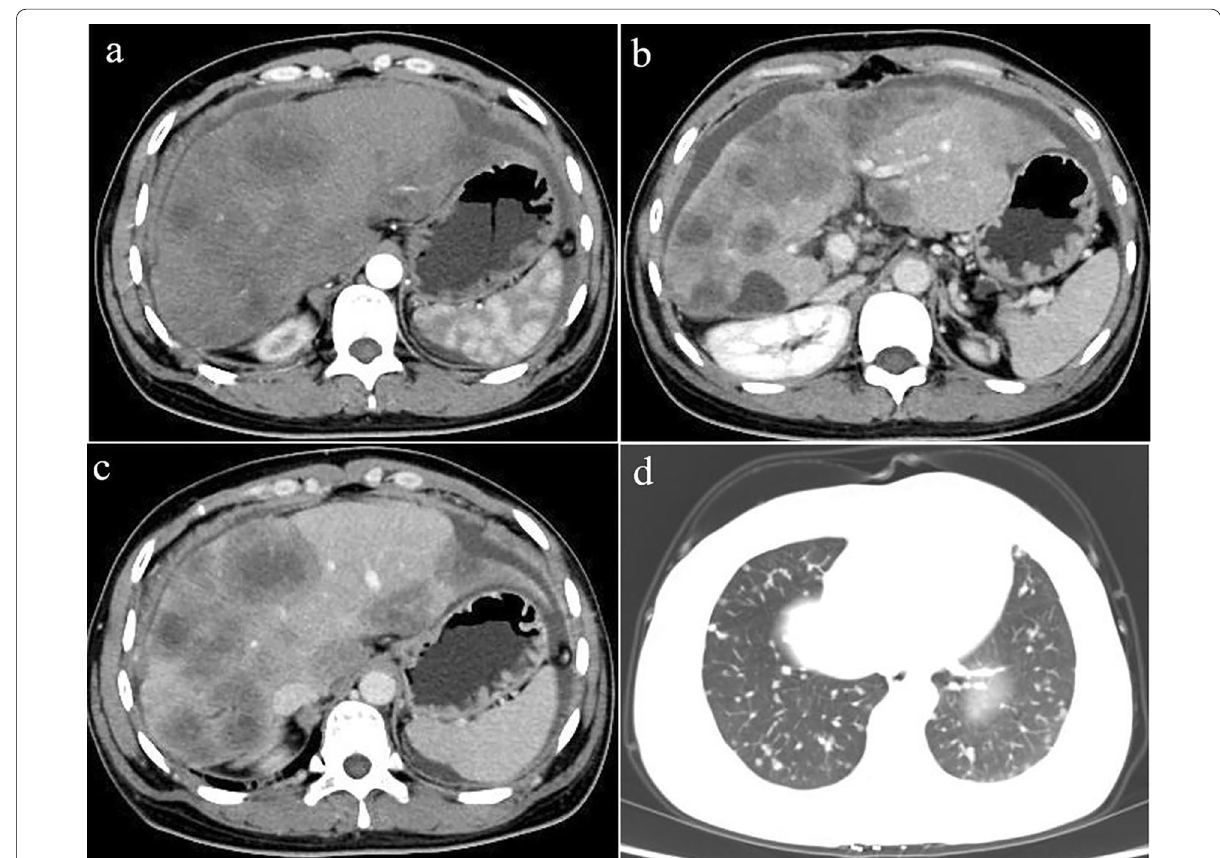
Fig. 5 A 34-year-old female with diffuse nodular type HEH. Axial and multiple phase contrast-enhanced CT images ( a – c ) show multiple, different-sized, coalescing, homogeneous, hypoattenuating nodules diffusing throughout the liver parenchyma. Masses show ring-like enhancement and the “target” sign. At the same time, there was arc-shaped effusion around the liver and peritoneal thickening. Peripheral distribution of masses and capsular retraction are also observed. The axial lung window image ( d ) shows lung involvement consisting of multiple round-like